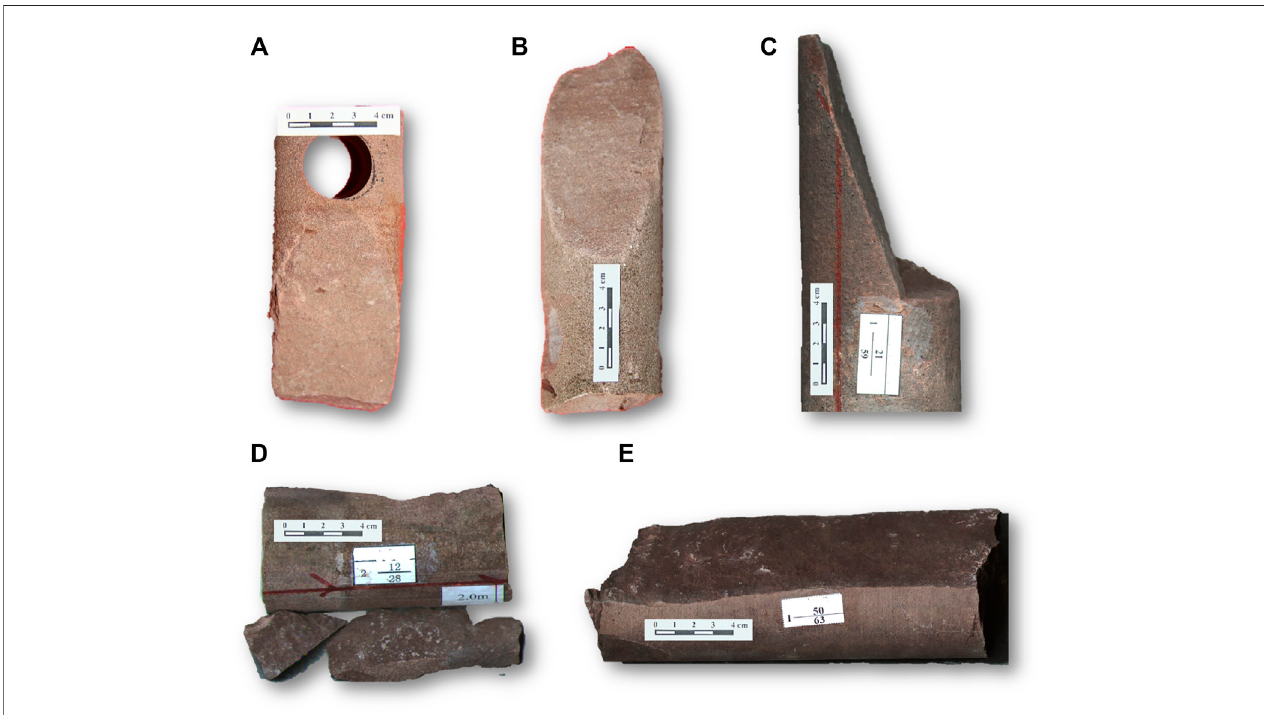
FIGURE 3 | (A) Well Z102, 6,779.20 m, un fi lled oblique shear fracture; (B) Well Z7, 7,742.96 m, un fi lled high angle oblique fracture; (C) Well Z901, 7,678.53 m, medium-highangleshearfracture, fl atfracturesurface; (D) WellZ104,6,846.75 m,agroupofun fi lledobliqueshearfracture,withbrokencore; (E) WellZ10,7,318.64 m, a nearly vertical shear fracture with fl at fracture surface.